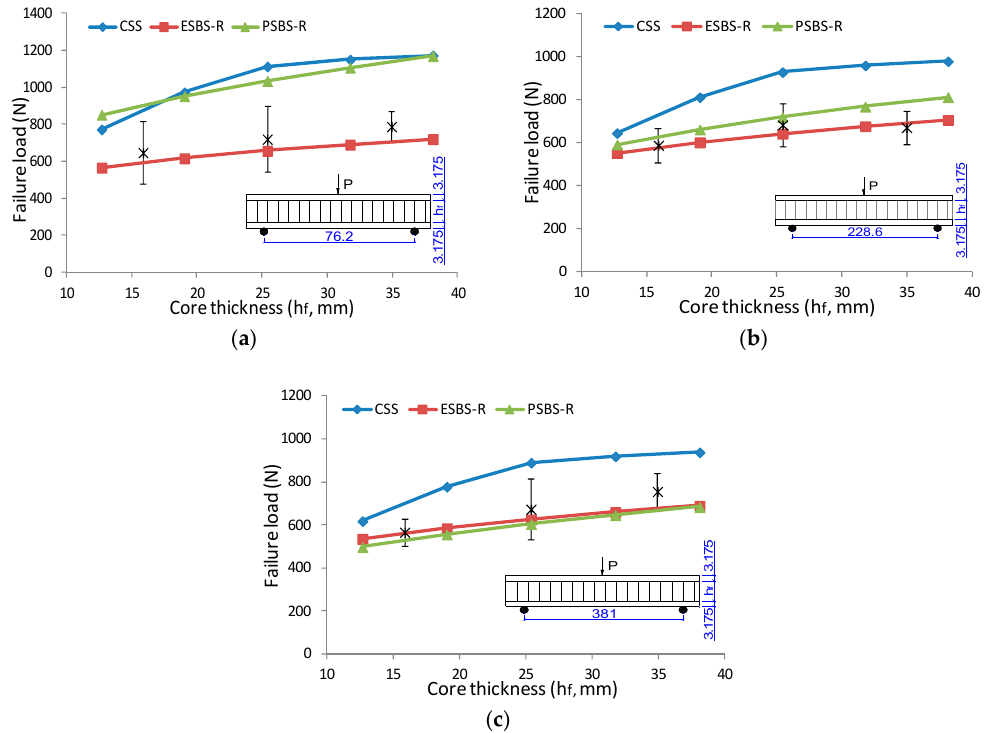
Figure 8. The effect of core thickness on failure load under a three-point bending test: ( a ) Sandwich beam with 3.175 mm MDF face under span of 76.2 mm; ( b ) sandwich beam with 3.175 mm MDF face under span of 228.6; ( c ) sandwich beam with 3.175 MDF face under span of 381 mm.